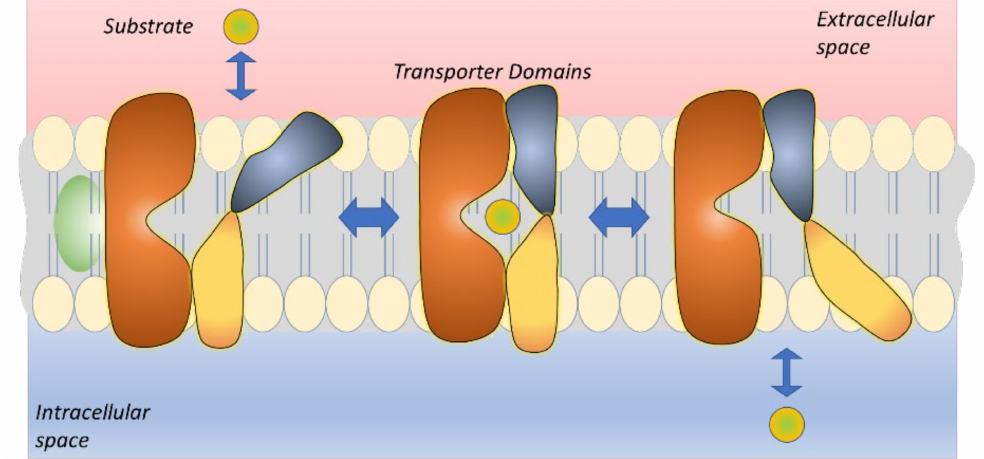
Figure 6. The rocking bundle transport mechanism of LAT1. The substrate (green ball-shape) is bound to the K-shaped transporter (outward-open state) on the extracellular side of the plasma membrane. The subsequent conformational movements of the transporter domains (first blue and then yellow shapes) result in the release of the substrate at the cytosolic side (inward-open